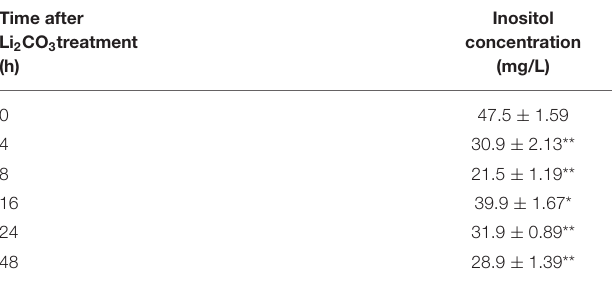
TABLE 3 | Dynamic changes of plasma inositol concentration in pregnant mice after Li 2 CO 3 (350 mg/kg) treatment. Time after Li 2 CO 3 treatment